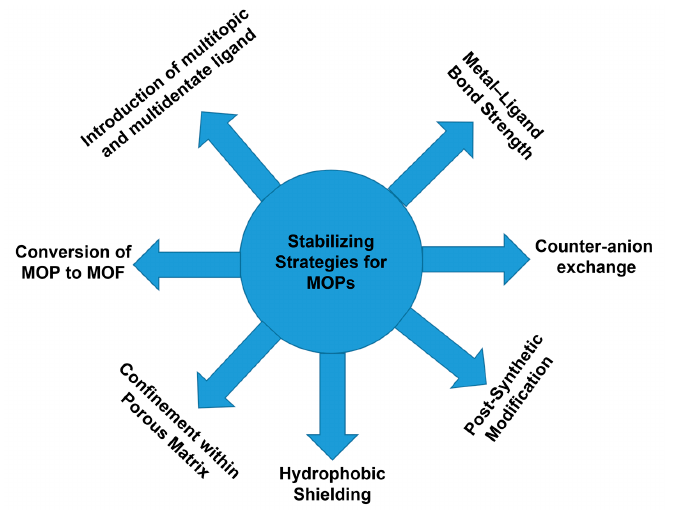
Figure 3. Schematic representation of design principles leading to hydrolytically stable porous MOPs in order to overcome the common instability limitations of MOPs.